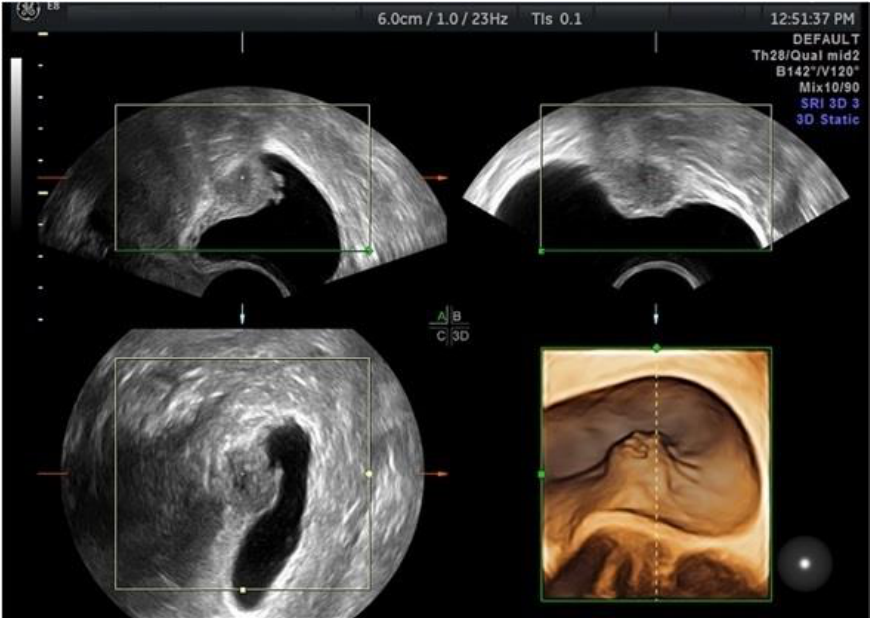
Figure 1. TVUS imaging method: a bladder endometriotic nodule with 2D TVUS (black and white images) and with 3D TVUS (color image).